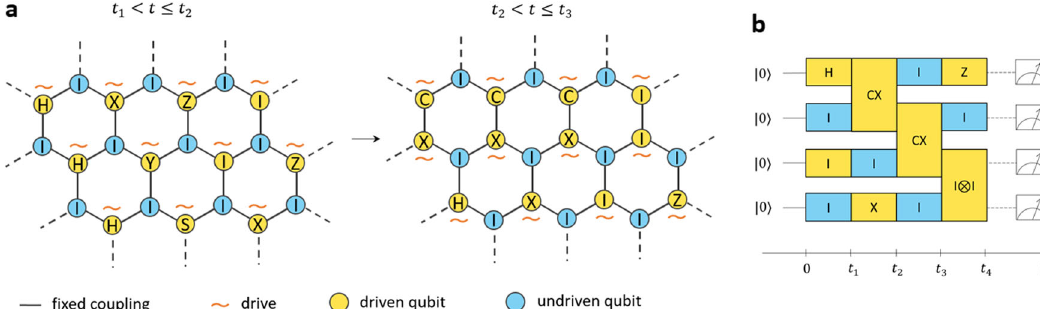
Fig. 1 Overview of the proposal. a An example of implementing quantum gates on an array of qubits with fi xed couplings. In any given step only a subarray can be driven. This subarray can be chosen to satisfy speci fi c requirements so that the array ’ s Hamiltonian can be decomposed into commuting few-qubit blocks. Each drive can implement a gate on the driven qubit, and through its combination with the fi xed qubit- qubit couplings also implements an identity operator on the neighbouring undriven qubits. In the next step, a different subarray is driven for implementing gates on a different set of qubits. Here C-X on two adjacent qubits denotes the CNOT gate and/the identity gate. b Illustration of a quantum circuit in our scheme. The key feature is that any idle interval between gates is fi lled with an identity gate for preventing unwanted evolution due to the fi xed couplings.